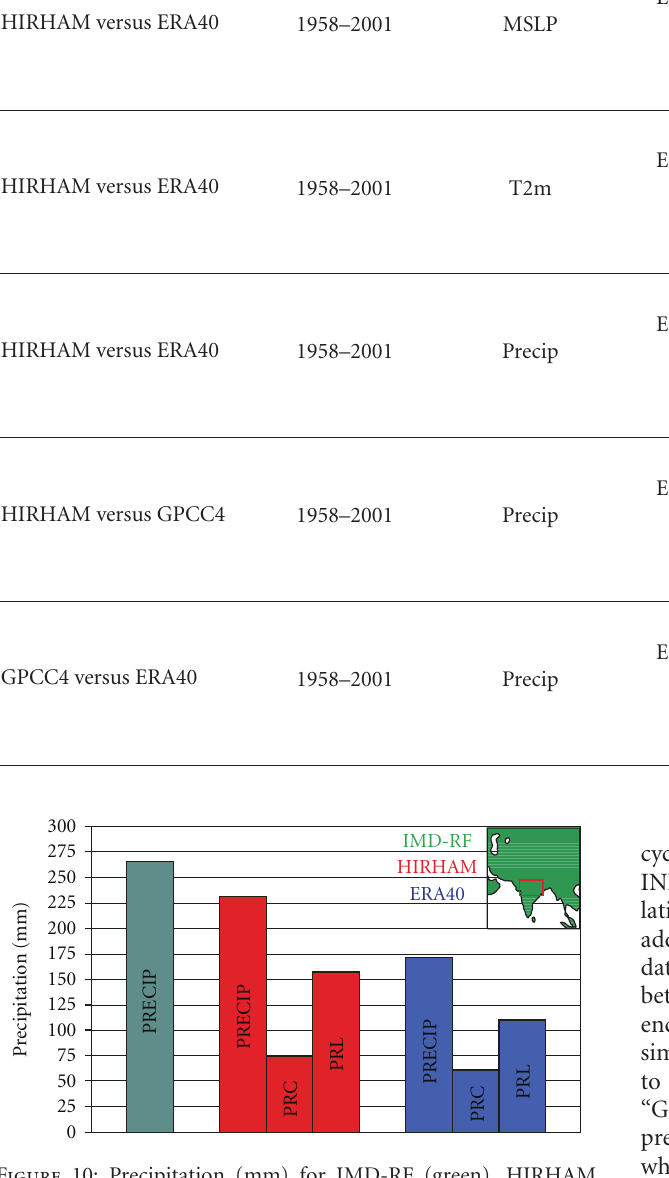
Figure 10: Precipitation (mm) for IMD-RF (green), HIRHAM (red), and ERA40 (blue) in a selected box of Indian land surface; summer monsoon (JJAS) 1958–2001: PRECIP = total precipitation, PRC = convective precipitation and PRL = large-scale